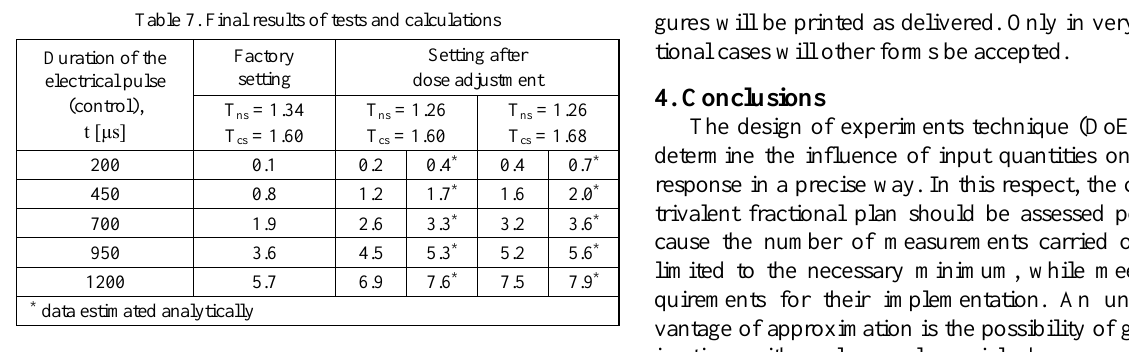
Table 7. Final results of tests and calculations Factory Duration of the setting electrical pulse (control), t [μs]